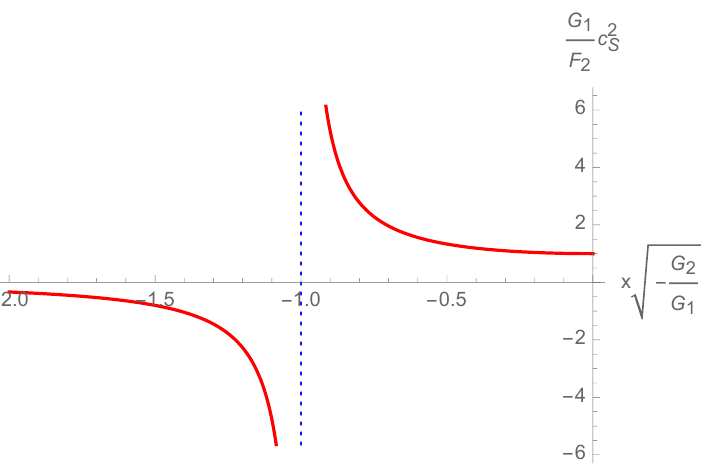
Figure 1 . The behavior of the c 2 , as a typical time-dependent coe(cid:14)cient in the dispersion relation, S as a function of time when sign( G 1 G 2 ) < 0. There is a singularity in time and a change in sign of the coe(cid:14)cients at the singularity. When the physical wavelength of the mode is very small, the speed of sound (and other coe(cid:14)cients of the dispersion relation) go to zero. When (cid:3) H for each mode, there will be a loss of unitarity for each mode. The parameters in the problem are tuned such that this loss of unitarity happens well before the transition from ! 2 (cid:24) k 6 to the ! 2 (cid:24) k 4 which guarantees that the mode spends a substantial amount during the sextic dispersion relation and make it